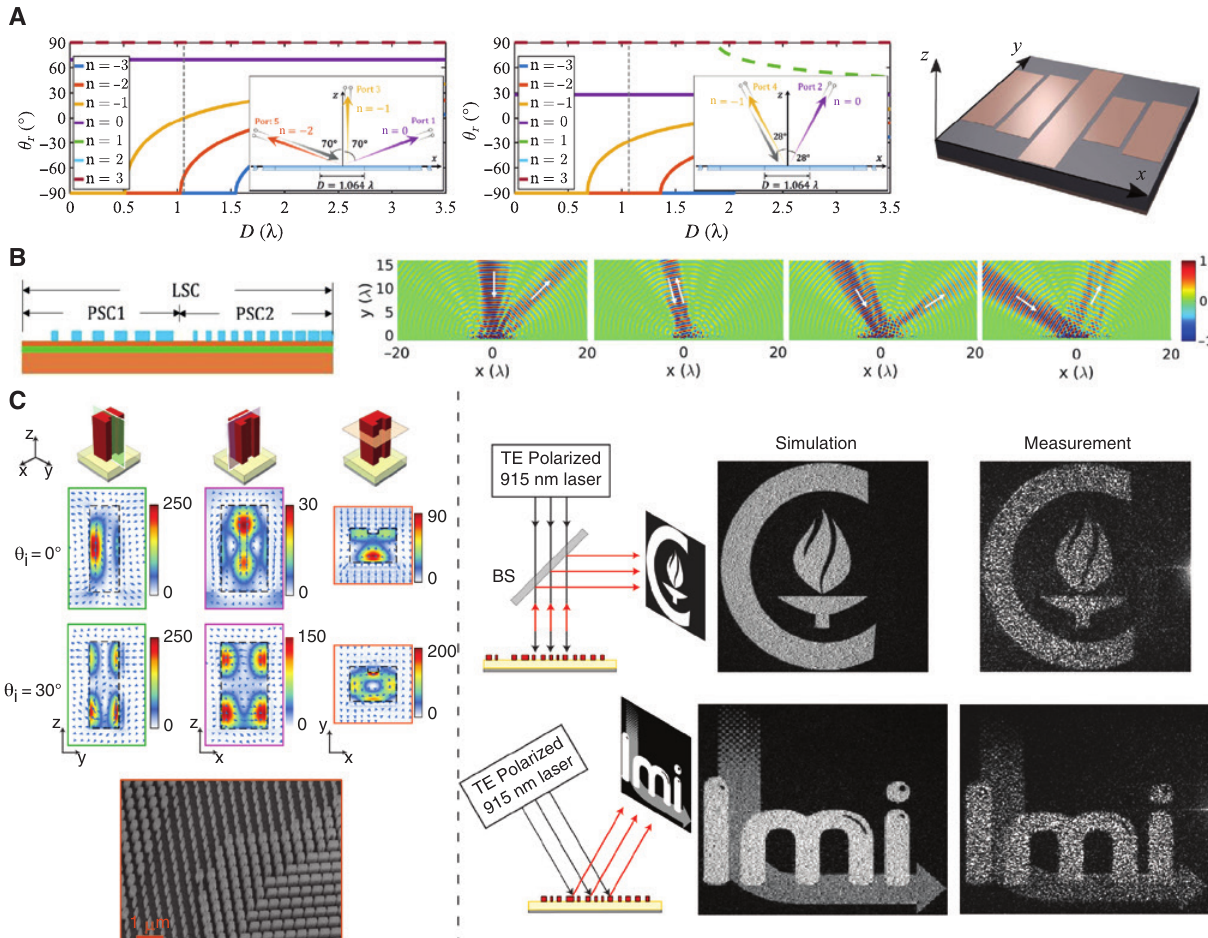
Figure 5: Metasurfaces with angular response control. (A) Multichannel control of microwave metasurfaces through use of allowed and prohibited diffraction channels. Left and middle: A slightly super-wavelength Littrow grating (the period is shown with the dashed black line) that retroreflects under five different blaze angles [193]. Right: schematic of the platform used to demonstrate multiangle metasurfaces. (B) One-dimensional high-contrast dielectric reflective gratings numerically optimized to blaze different diffraction orders under illumination from different input angles [194]. (C) High-contrast dielectric reflectarray designed to provide independent phase control under two different incident angles [14]. The U-shaped meta-atom allows for independent control of symmetric and antisymmetric modes inside it, thus enabling devices with independent arbitrary functions at different incident angles. Gratings with different moments and holograms projecting different images were